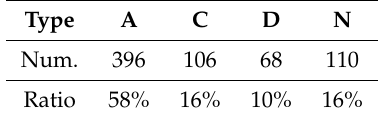
Table 2. Statistics of the identified warm filament types.